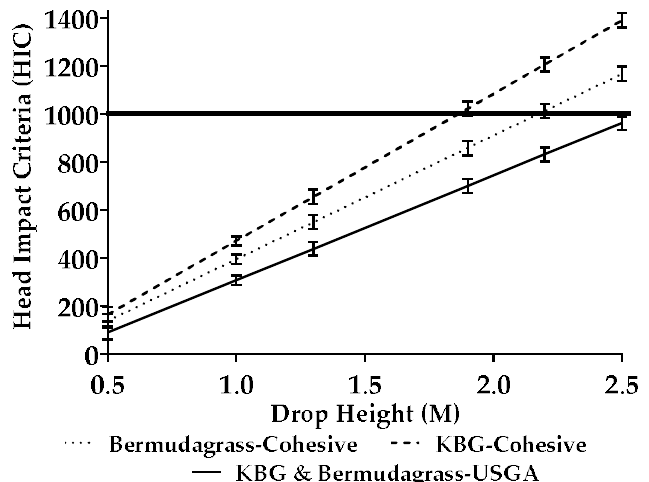
Figure 1. Head injury criterion response to changes in drop height on grass species ( Poa pratensis (KGB) and Cynodon dactylon × C. transvaalensis (bermudagrass)) and root zone (Sequatchie silt loam (Cohesive) and United States Golf Association sand specification (USGA)) in 2016 and 2017. Error bars represent Fisher’s LSD values at α ≤ 0.05 as a means of statistical comparison. Black line in graph represents the critical threshold when ≤1000